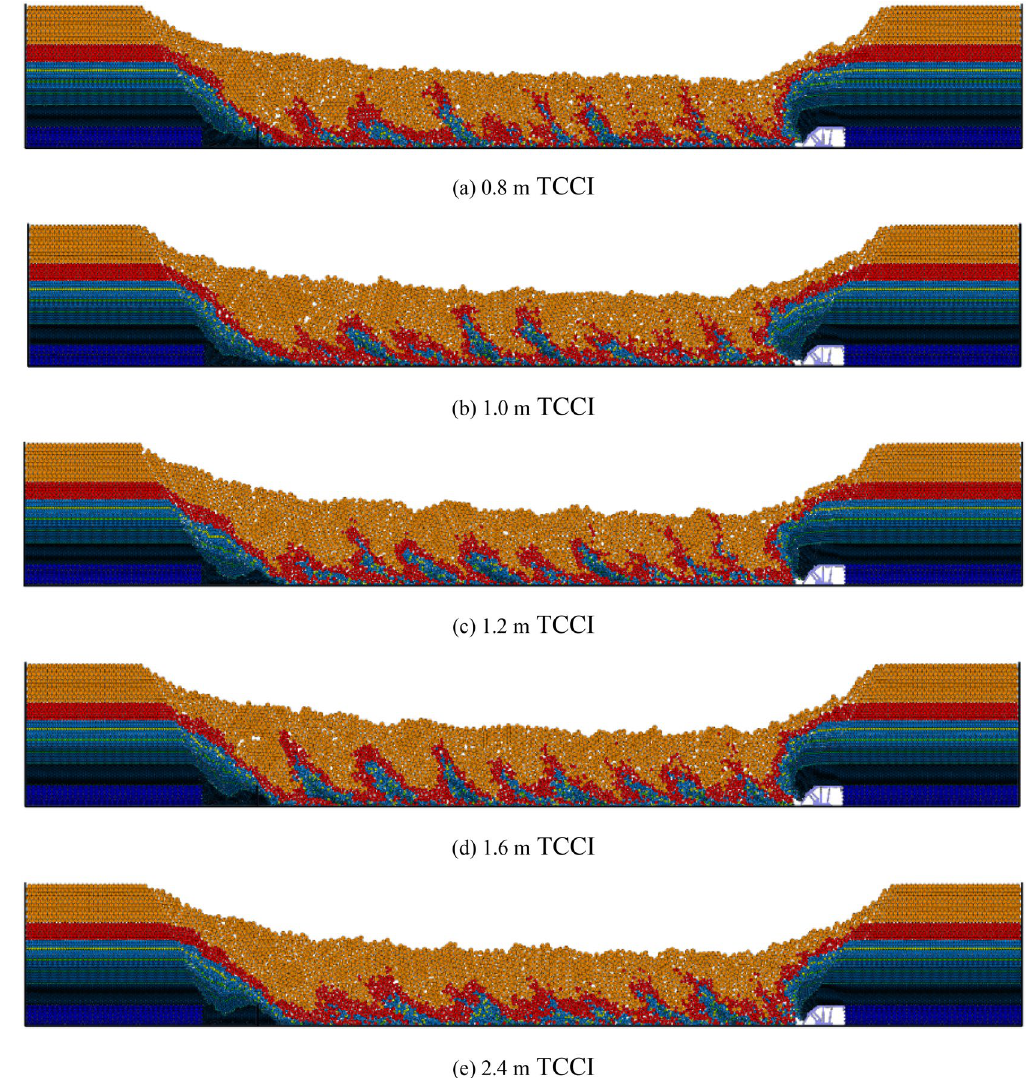
Figure 6. Loss of top coal in different coal-drawing interval under 12.0 m top coal